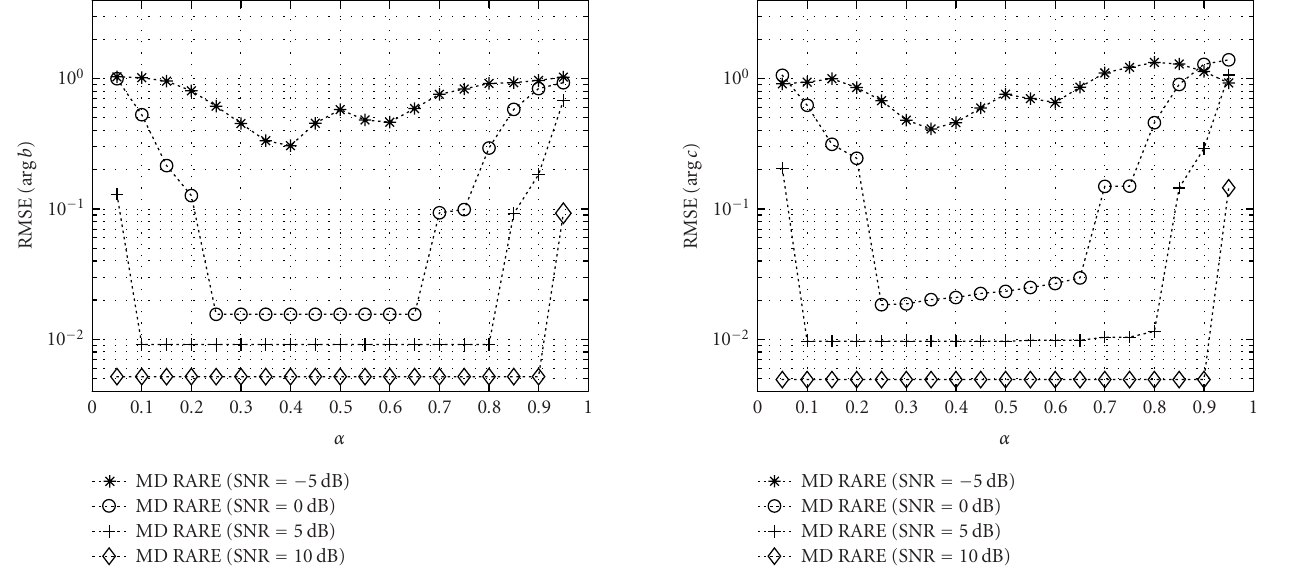
Figure 2: Root mean squared error of 3D RARE versus α .